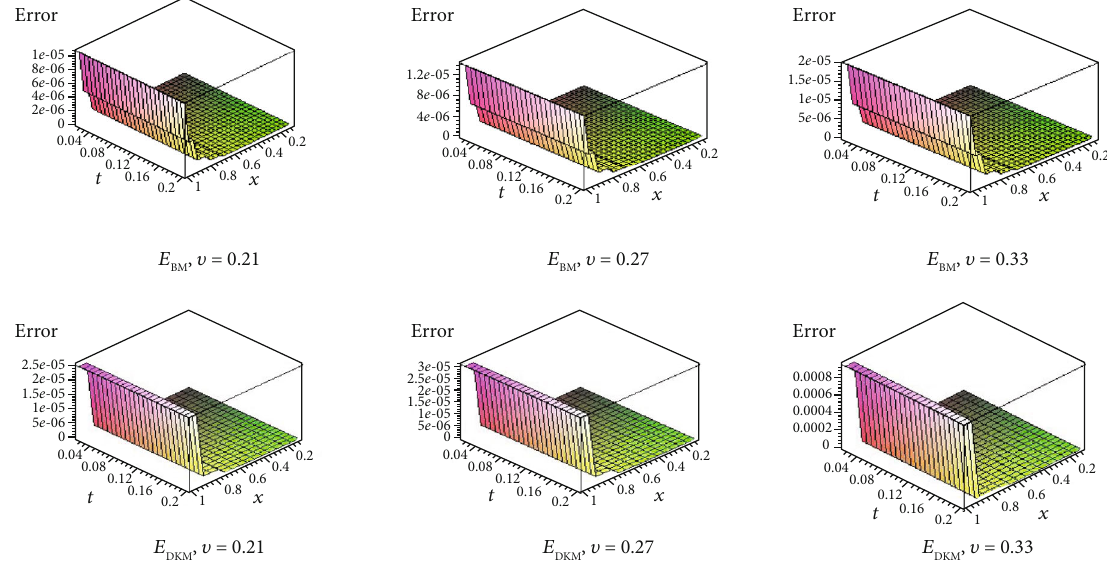
Figure 7: The values of errors by B-by-BM and DKM at T = 0 : 2 , N = 10 , and k = 2 for υ = 0 : 21, 0 : 27, 0 : 33 .